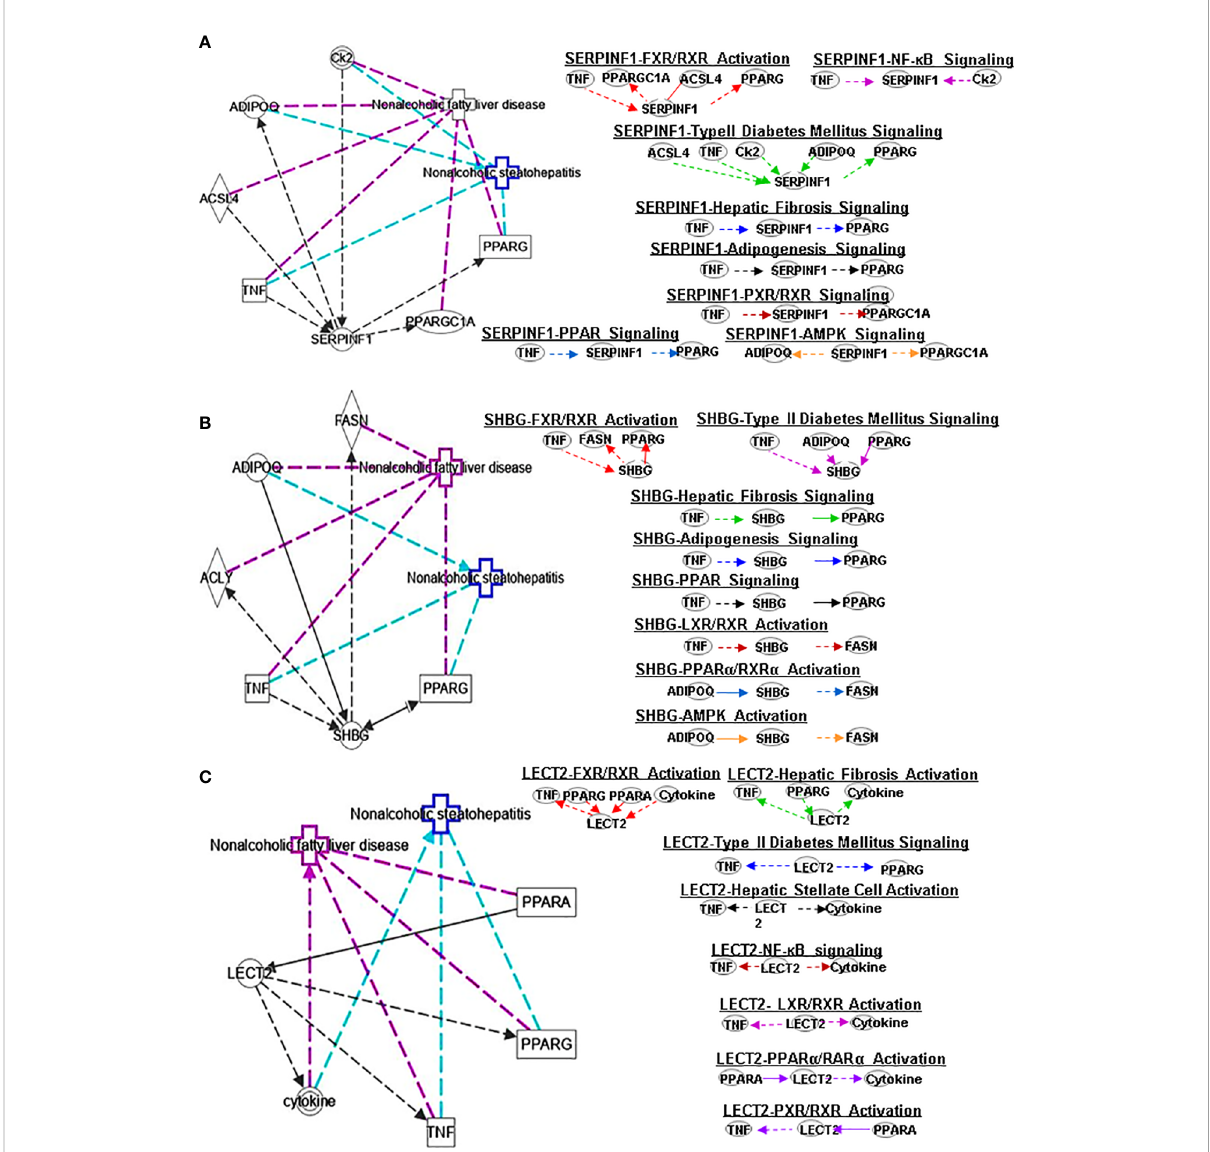
FIGURE 4 Ingenuity pathway analysis (IPA) of SERPINF1, SHBG and LECT2. (A) IPA investigated the molecular pathways of SERPINF1 involved in NAFLD and NASH. All identi fi ed pathways of SERPINF1 were screened individually. Representative canonical pathways of SERPINF1 are associated with other related genes and molecules of NAFLD and NASH. Functional relationships of these genes, molecules and SERPINF1 are depicted using straight lines with arrows. SERPINF1 is functionally related to 1. FXR/RXR signaling; 2. NF- k B signaling; 3. Type 2 Diabetes Mellitus signaling; 4. Hepatic fi brosis signaling; 5. Adipogenesis signaling; 6. LXR/RXR signaling; 7. PPAR a /RXR a signaling and 8. AMPK signaling (Right). (B) IPA investigated the molecular pathways of SHBG involved in NAFLD and NASH. All identi fi ed pathways of SHBG were screened individually (left). Representative canonical pathways of SHBG are associated with other related genes and molecules of NAFLD and NASH. Functional relationships of these genes and SHBG are depicted using straight lines with arrows. SHBG is functionally related to 1. FXR/RXR signaling; 2. Type 2 Diabetes Mellitus signaling; 3. Hepatic fi brosis signaling; 4. Adipogenesis signaling; 5. LXR/RXR signaling; 6. PPAR a /RXR a signaling and 7. AMPK signaling (Right). (C) IPA investigated the molecular pathways of LECT involved in NAFLD and NASH. All identi fi ed pathways of LECT were screened individually (left). Representative canonical pathways of LECT are associated with other related genes and molecules of NAFLD and NASH. Functional relationships of these genes and LECT are depicted using straight lines with arrows. LECT is functionally related to 1. FXR/RXR signaling; 2. Hepatic fi brosis signaling; 3. Type 2 Diabetes Mellitus signaling; 4. Hepatic stellate cell signaling; 5. NF- k B signaling; 6. LXR/RXR signaling; 6. PPAR a /RXR a signaling and 7. PXR/RXR signaling (Right). Solid lines show direct regulation while dotted lines depict indirect